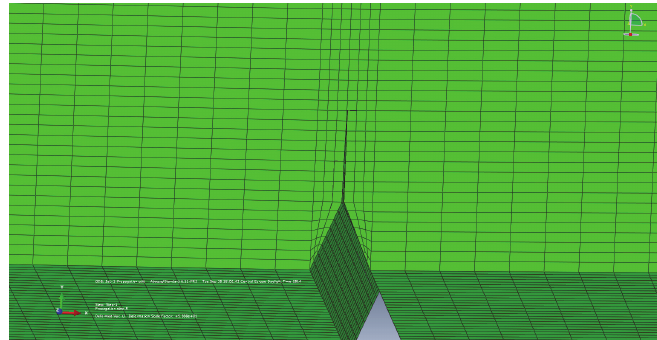
Figure 3: Crack length after 8 th step.